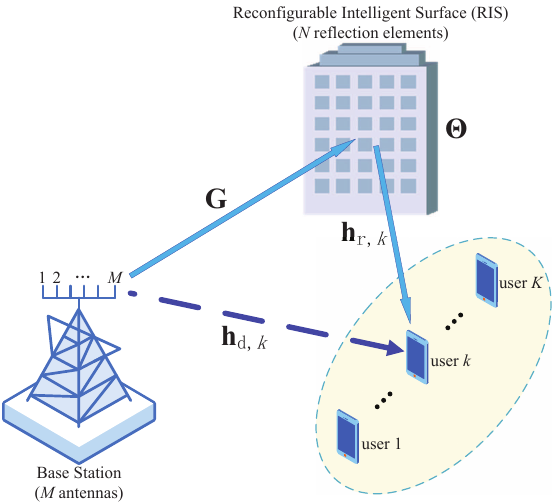
Figure 1. The reconfigurable intelligent surface (RIS)-aided multi-user multiple-input single-output (MISO) downlink